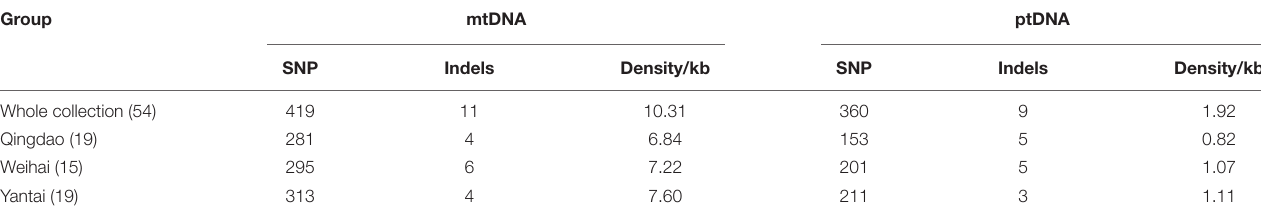
TABLE 1 | Summary of the total SNPs and indels detected in Pyropia yezoensis organellar genomes. Group mtDNA ptDNA SNP Indels Density/kb